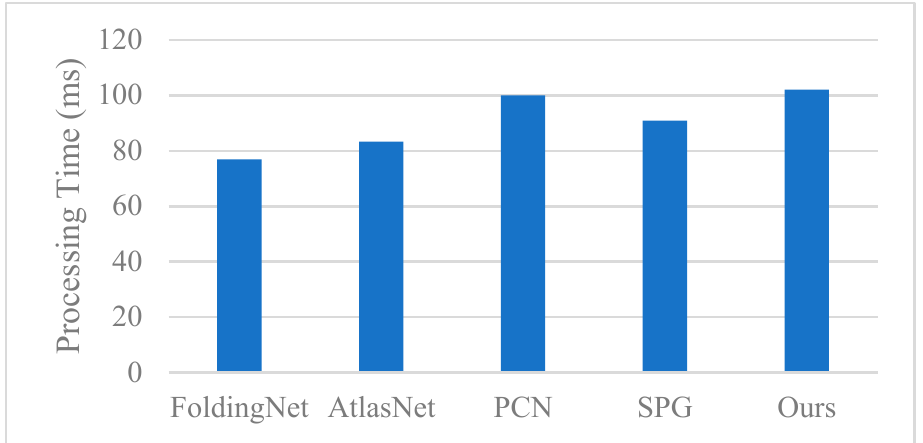
Figure 10. Speed comparison of different models.